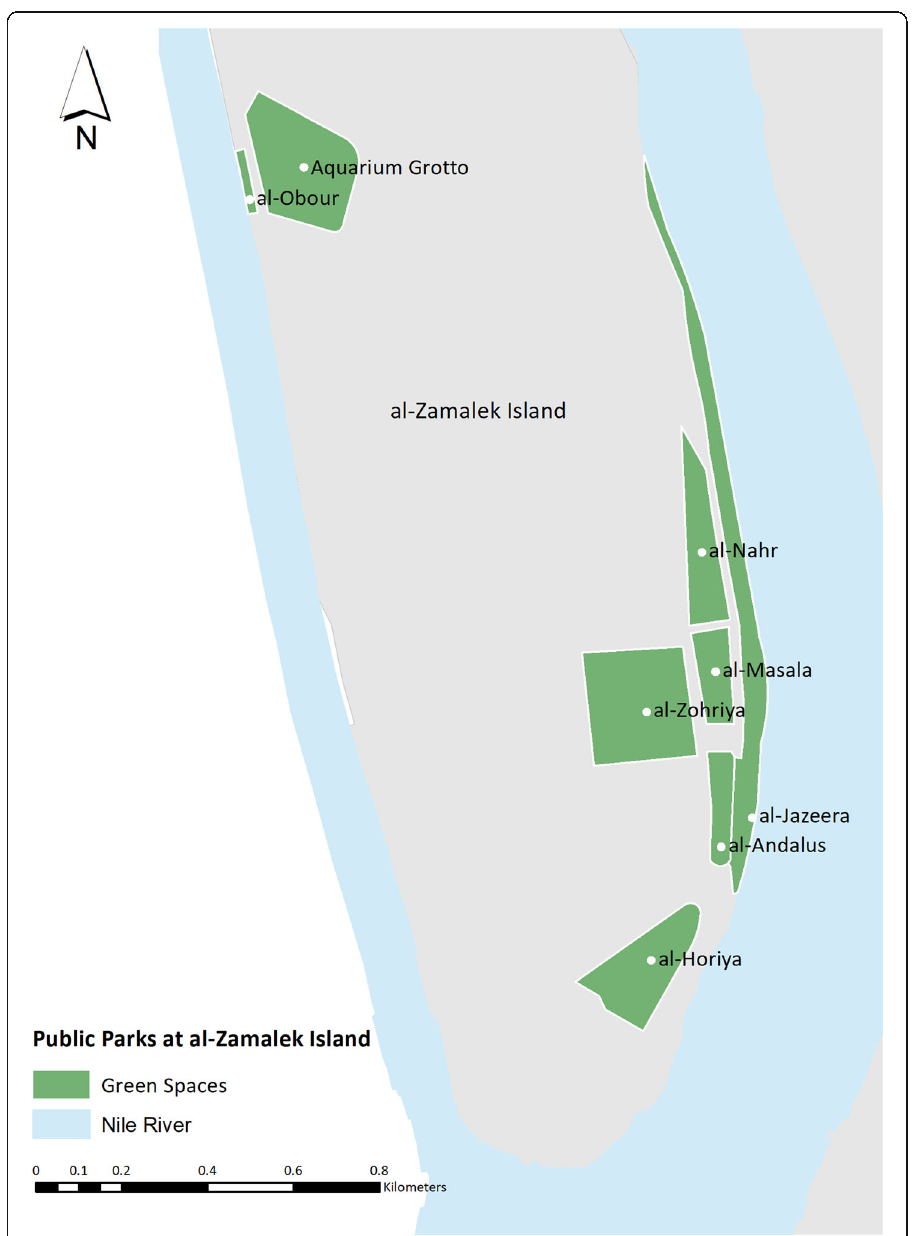
Fig. 14 Fragmentation of Public Parks at